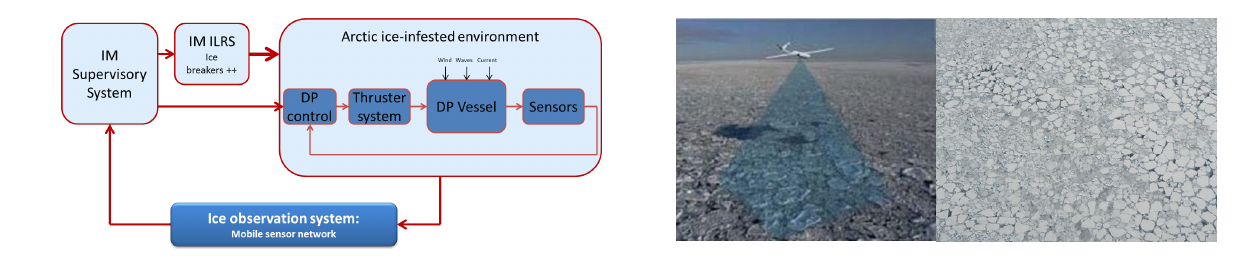
DP operation. The cameras are used as sen- sors on the Unmanned Aerial Vehicle (UAV) to monitor the conditions of